Question: State the chart type depicted above.
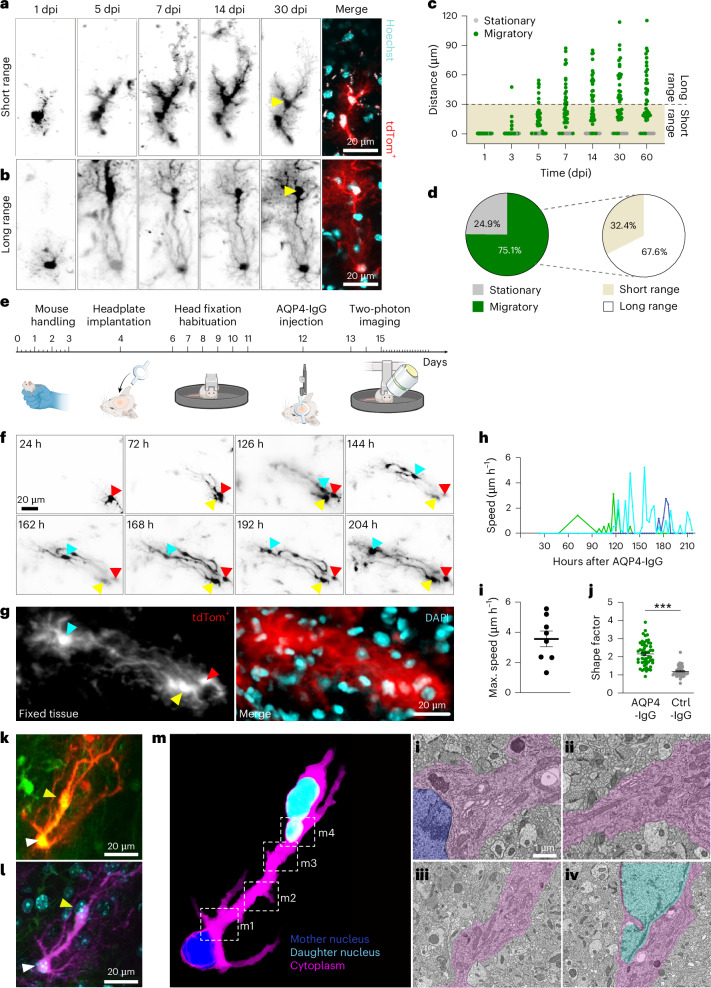
Answer: bar